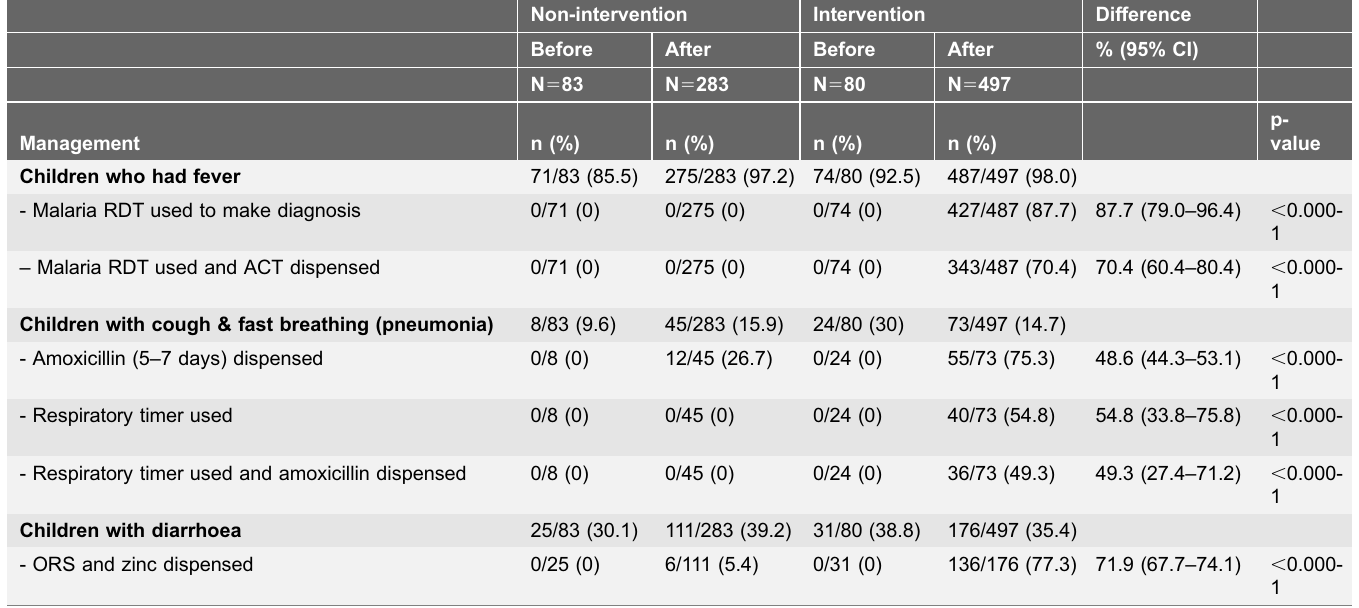
Table 2. Symptoms and management of fever, cough with fast breathing and diarrhoea in children below 5 years of age at drug shop exit interviews (survey adjusted). Non-intervention Intervention Difference Before After Before